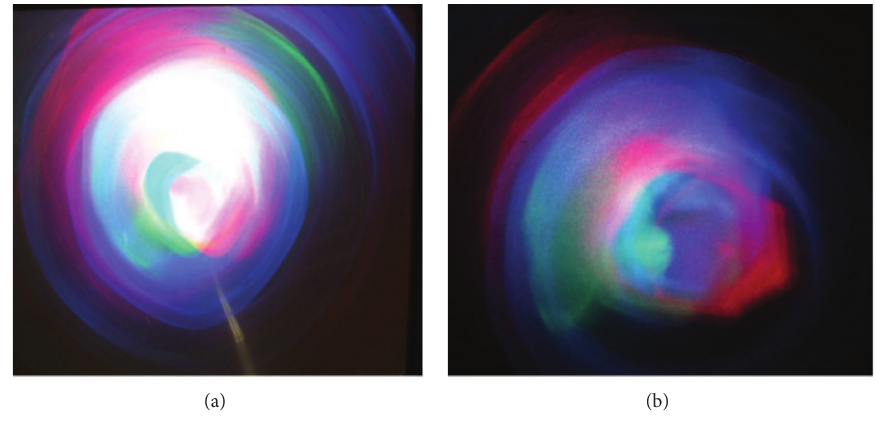
Figure 20: Photographs of experimental results